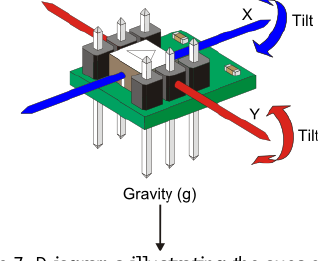
Figure 7. Diagrams illustrating the axes of 2-axis (Source: IEEE GlobalSpec, 2016)